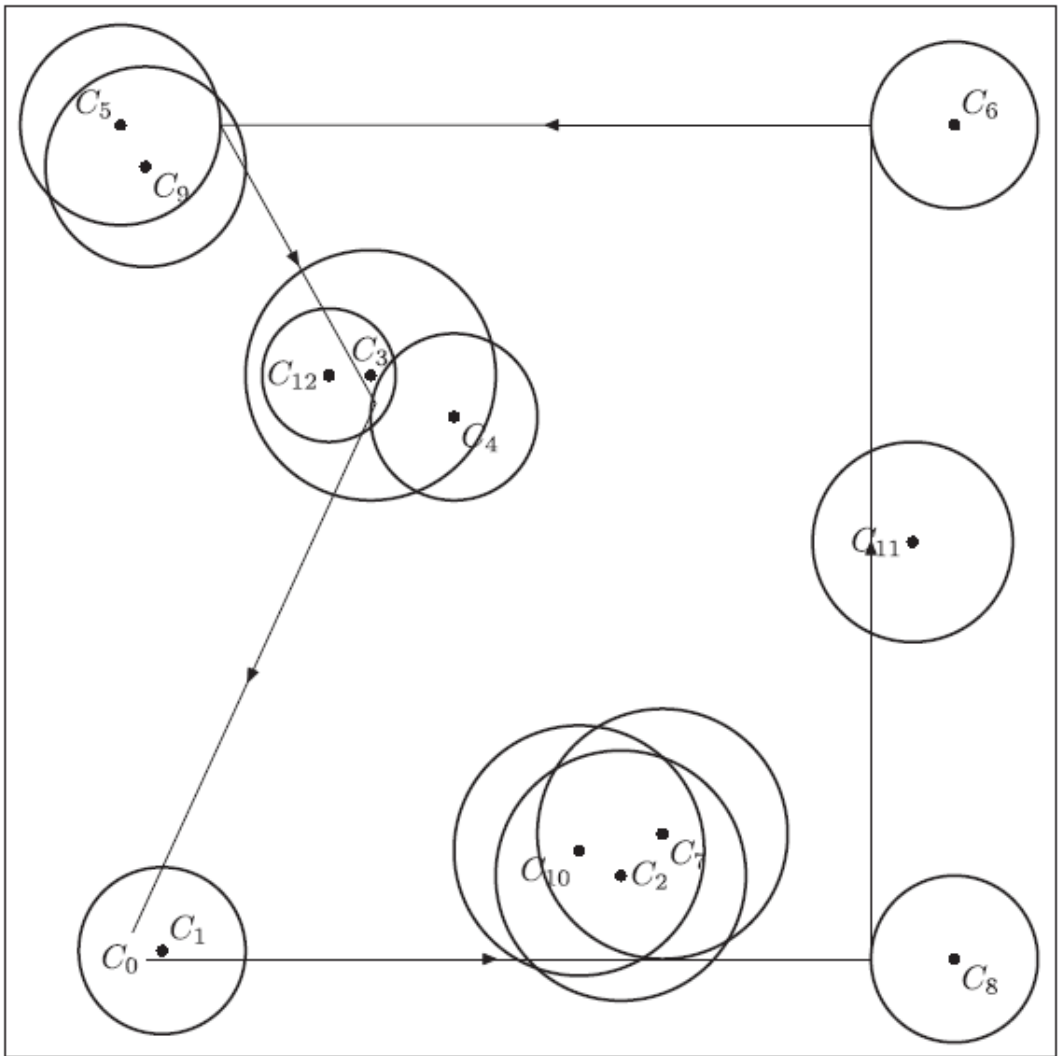
Figure 1. An instance of a CETSP with 12 customers